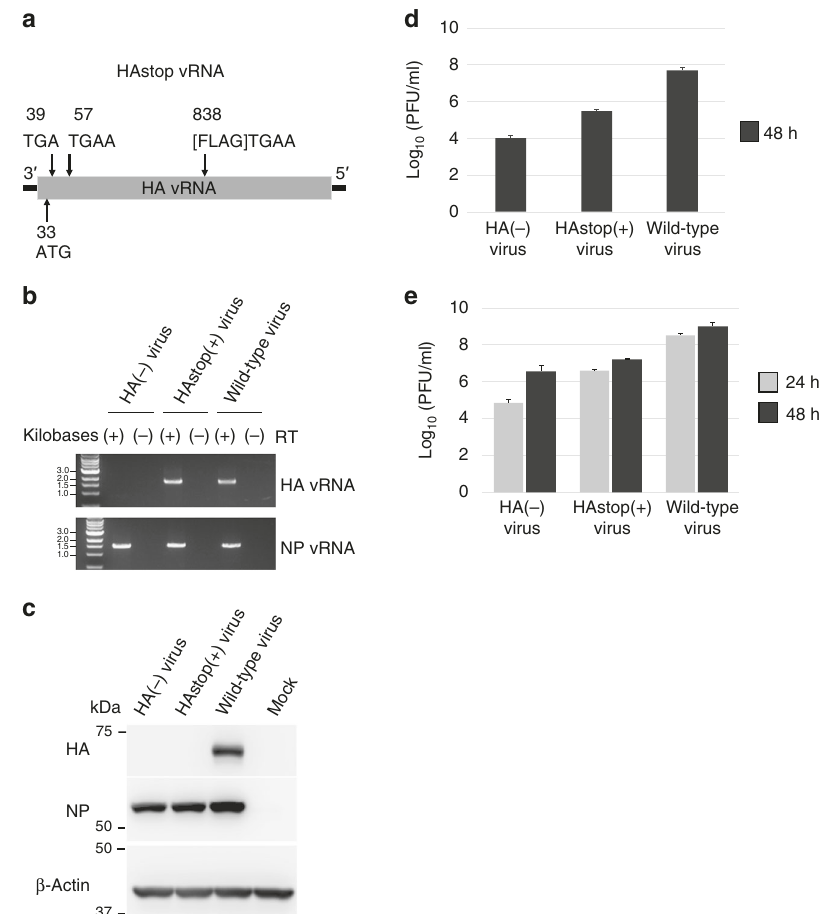
Fig. 1 Generation of mutant in fl uenza A viruses by use of reverse genetics. a Schematic diagram of a mutant HA vRNA (HAstop) that does not produce HA protein. It contains two stop codons and a FLAG epitope (Asp-Tyr-Lys-Asp-Asp-Asp-Asp-Lys) followed by a stop codon, in-frame with the HA reading frame. The numbers indicate the nucleotide positions from the 3 ′ end of the HA vRNA. Neither the HA protein nor the FLAG protein were detected by western blot analysis in cells transfected with this construct, using anti-HA and anti-FLAG antibodies. b RT-PCR analysis of the mutant viruses. The extracted vRNAs from the supernatants of plasmid-transfected cells were reverse-transcribed using a primer that was complementary to the conserved 12 nucleotides of the 3 ′ end of all eight vRNAs, followed by ampli fi cation by PCR with strand-speci fi c primers for NP or HA vRNA. Reverse transcriptase (RT) reactions were performed with or without reverse transcriptase. c MDCK cells were infected with HA( − ), HAstop(+), and wild-type viruses, respectively. At 12 h postinfection, the cell lysates were subjected to western blot analysis using anti-HA and anti-NP monoclonal antibodies. d 293T cells were transfected with plasmids to produce the HA( − ), HAstop(+), and wild-type viruses. Virus yields were determined at 48 h post-transfection by use of plaque assays on HA-MDCK cells. The data represent the mean ± SD ( n = 3). e HA-MDCK cells were infected with the respective viruses at an MOI of 0.01, and the culture media were harvested at 24 and 48 h postinfection. The virus titers were determined by use of plaque assays on HA-MDCK cells. The data represent the mean ± SD ( n =